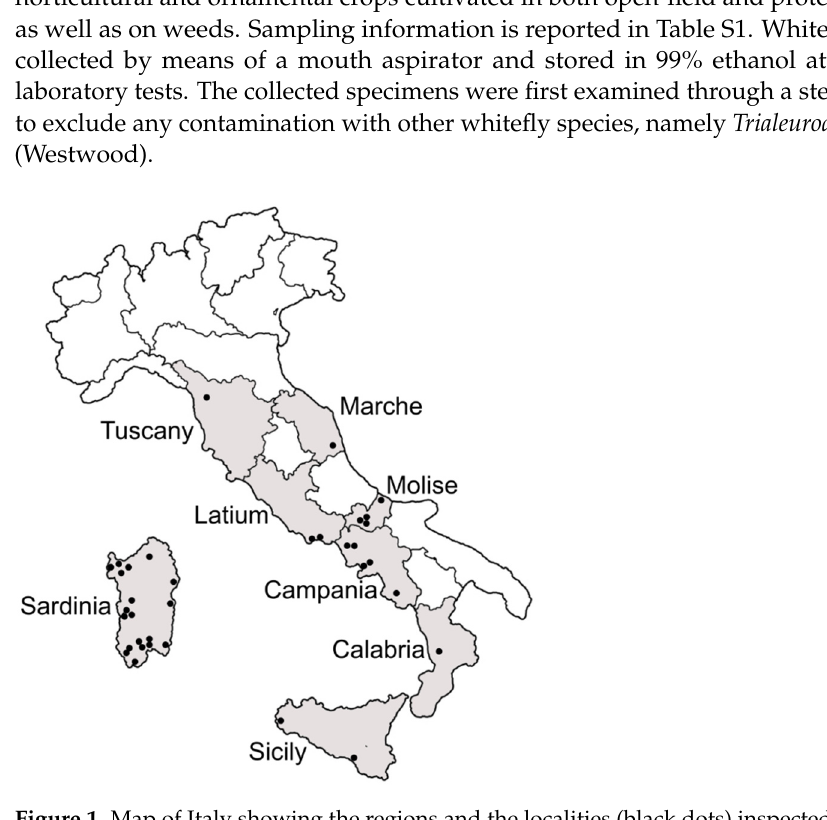
Figure 1. Map of Italy showing the regions and the localities (black dots) inspected for the presence of Bemisia tabaci .